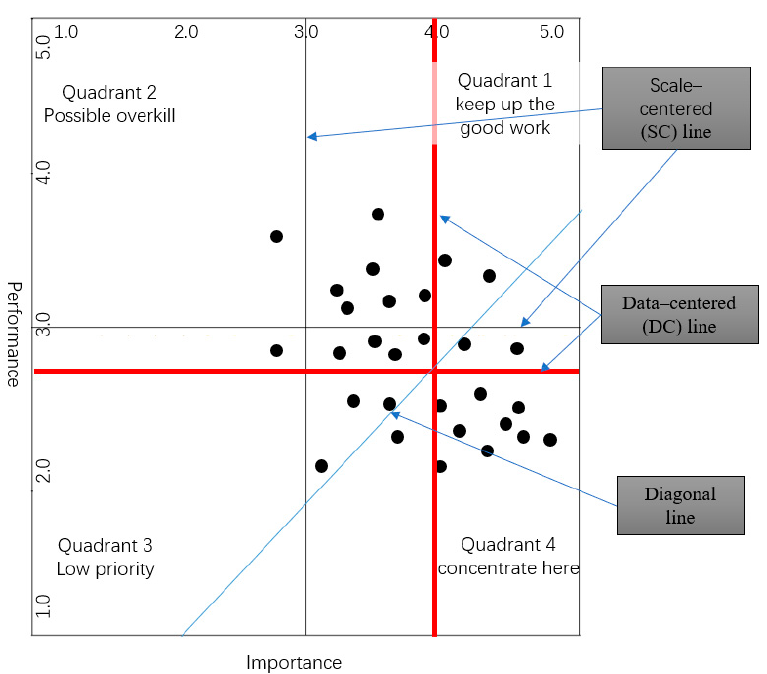
Figure 3. The line of different thresholds within the IPA plot.